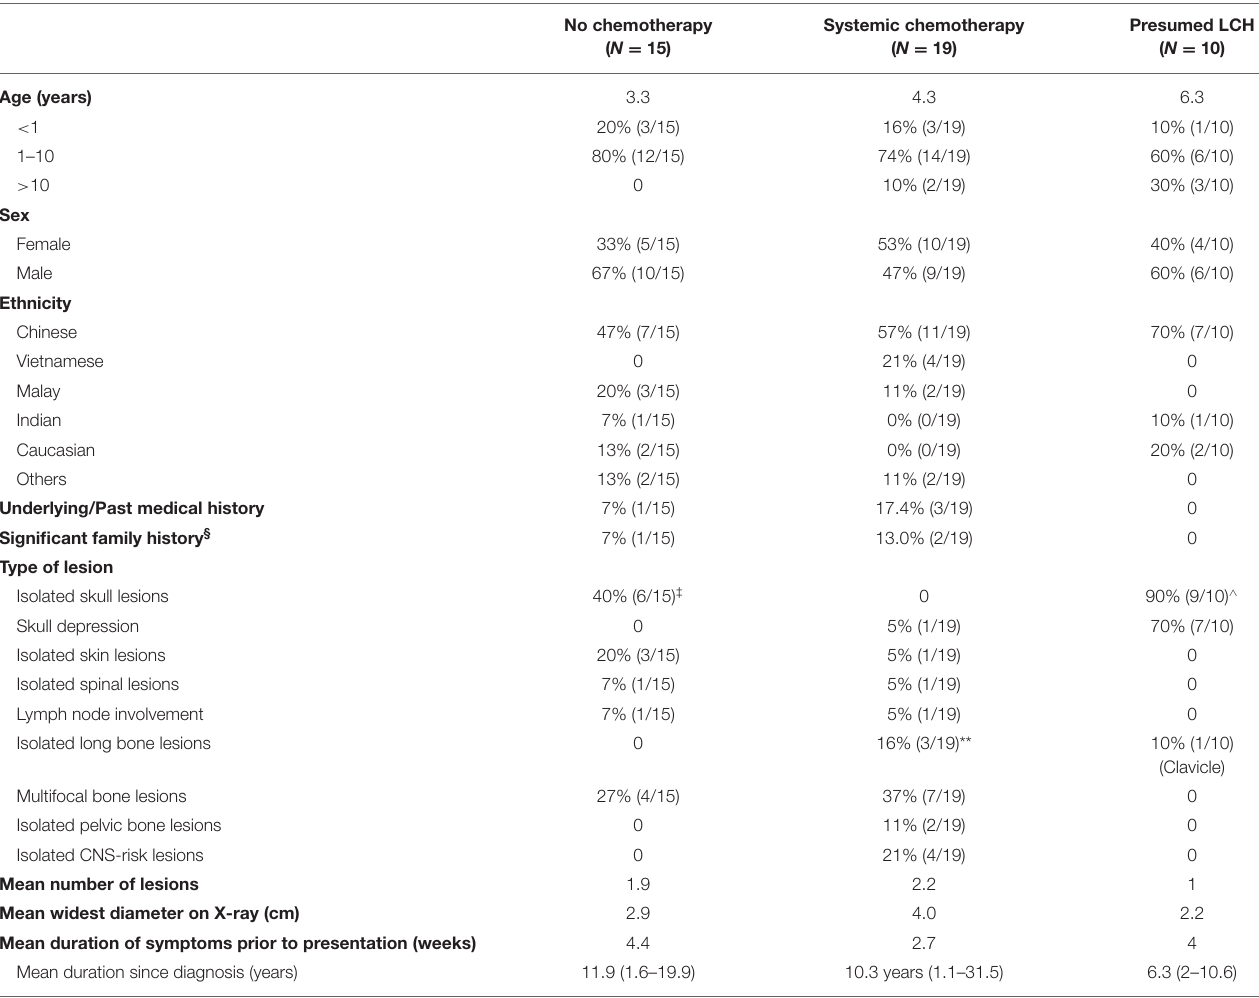
TABLE 2 | Baseline